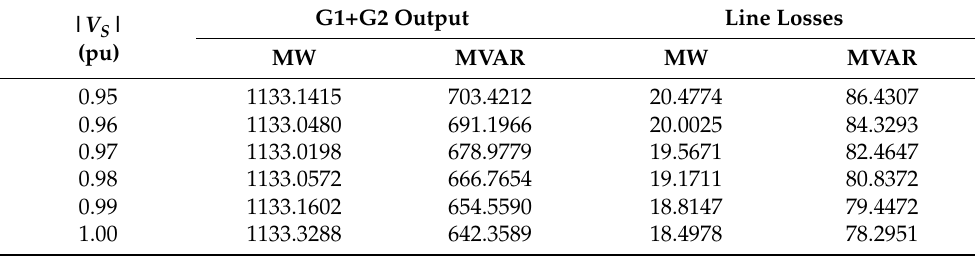
Table 12. G1+G2 output and line loss ( V w = 9